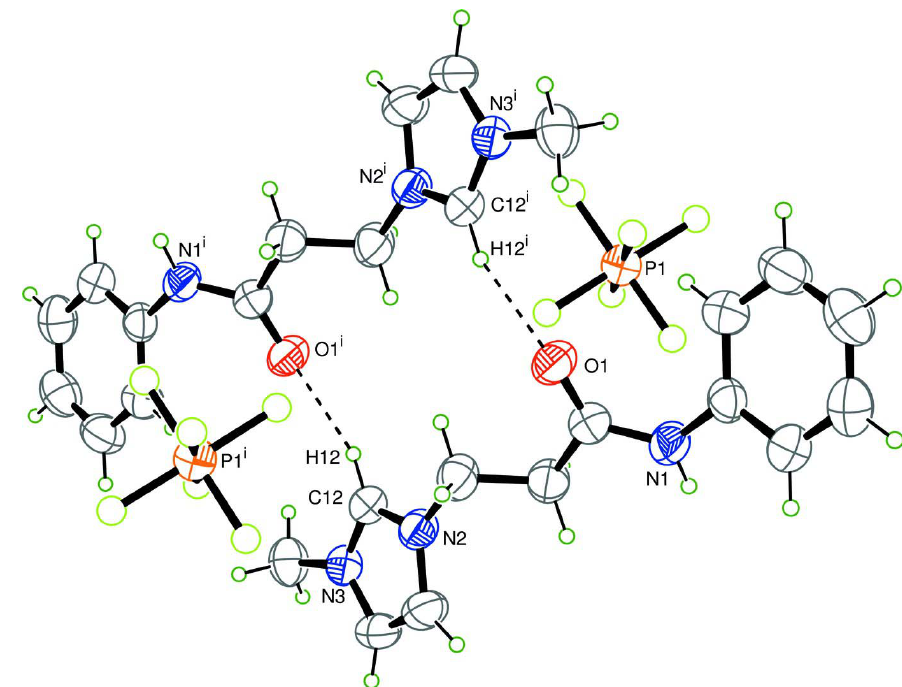
Figure 2 View of a hydrogen-bonded (dashed lines) dimers with the symmetry code: (i) 1 - x , - y , 1 - z